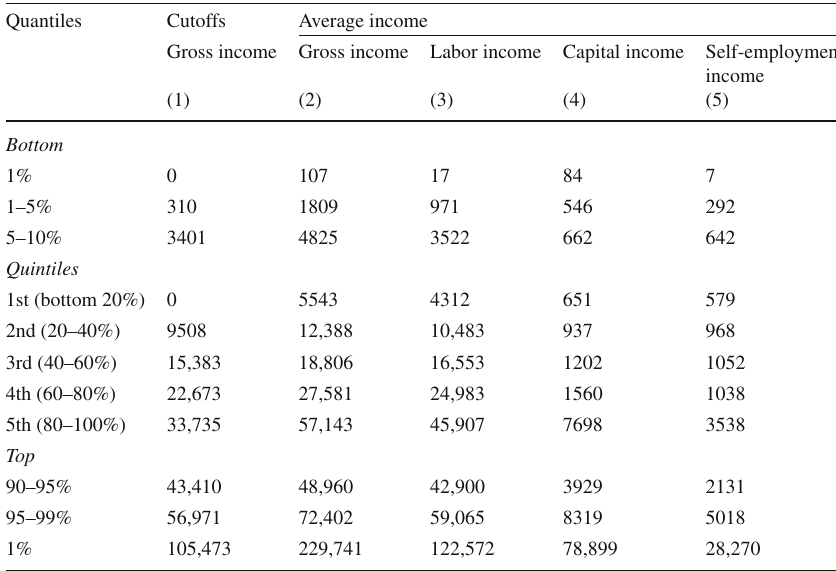
Table 4 Individual gross income cutoffs and average income levels ( e , 2015) Quantiles Cutoffs Average